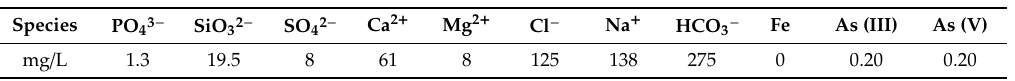
Table 1. Composition of the Synthetic Bangladesh Groundwater (SBGW) with arsenite and arsenate used in this